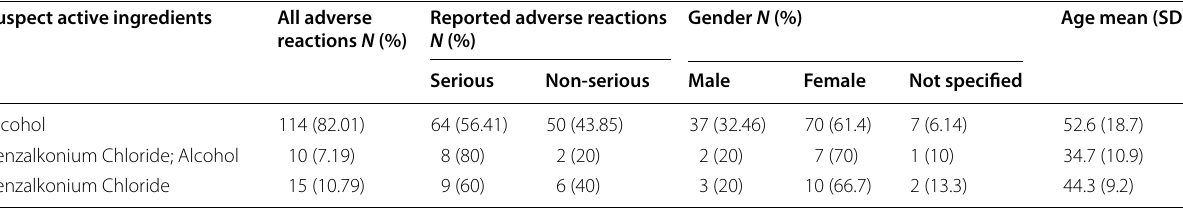
Table 1 Characteristics of adverse reactions which reported by food and drug administration adverse event reporting system